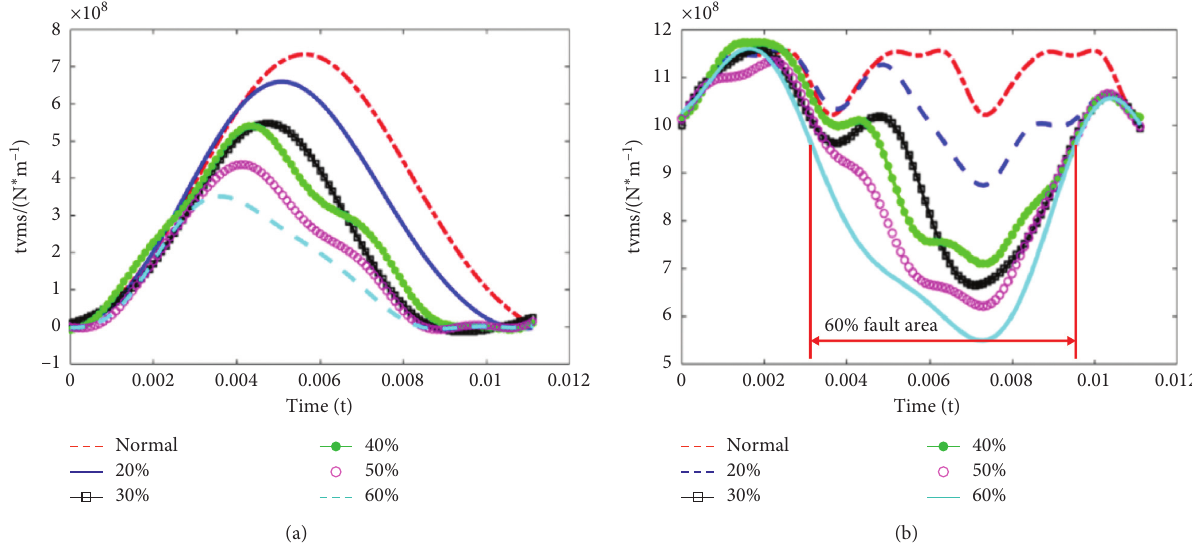
Figure 6: Time-varying meshing stiffness of spiral bevel gears with broken teeth: (a) tvms of single-teeth and (b) tvms of multitooth.